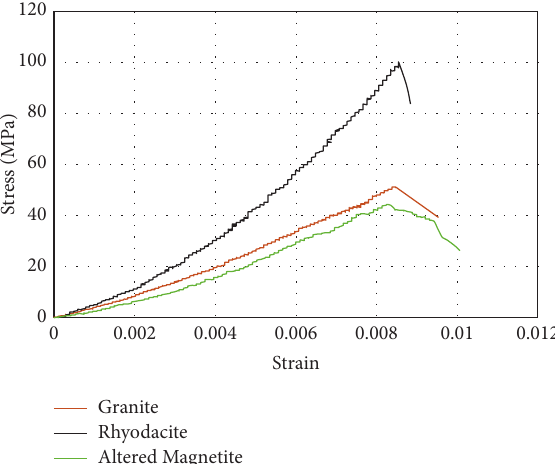
Figure 8: The stress-strain curves of the three rock